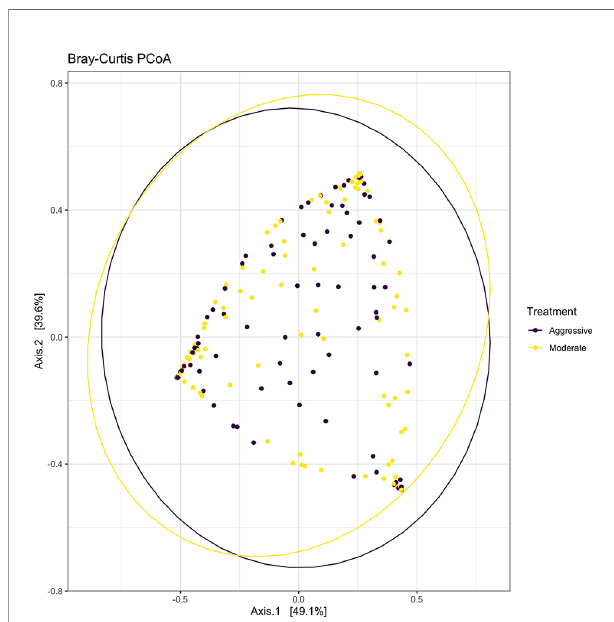
FIGURE 9 | Beta-diversity measurements for protozoal communities using Bray-Curtis distances to create a PCoA. Aggressive treatments are represented in purple and moderate treatments are represented in yellow. Ellipses represent 95% con fi dence intervals around means for aggressive and moderate implant strategies. Signi fi cant overlap between communities reveals no differences between moderate or aggressive treatments.